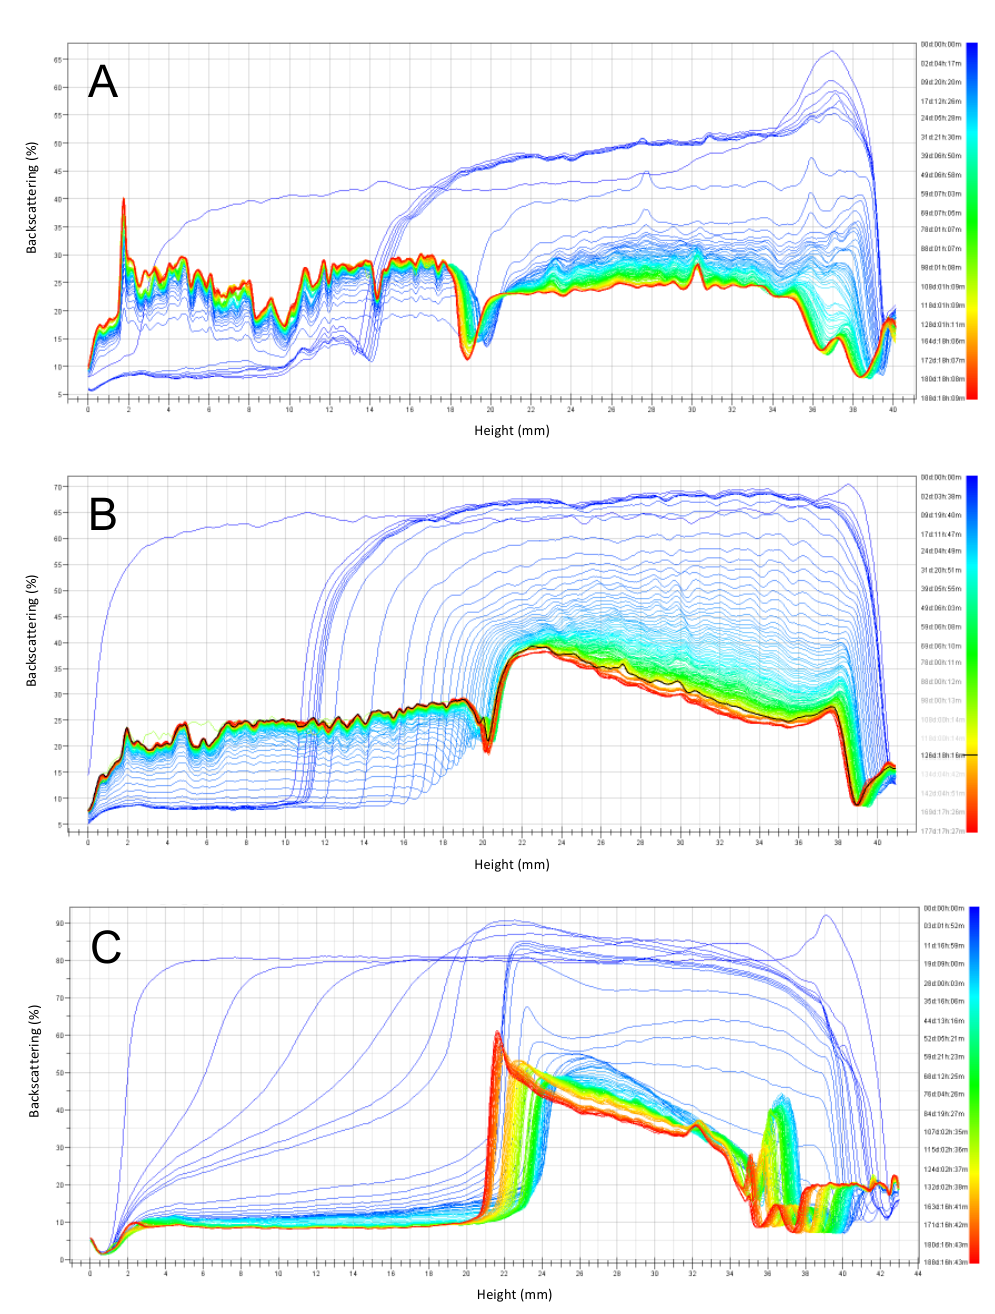
Figure 8. Emulsions backscattering profiles prepared at pH 3 and stored six months at 30 °C. ( A ) Emulsions stabilized by rapeseed protein precipitated at pH 3 (RPP3), ( B ) Emulsions stabilized by rapeseed protein precipitated at pH 6.5 (RPP6.5), ( C ) Emulsions stabilized by soy lecithin.